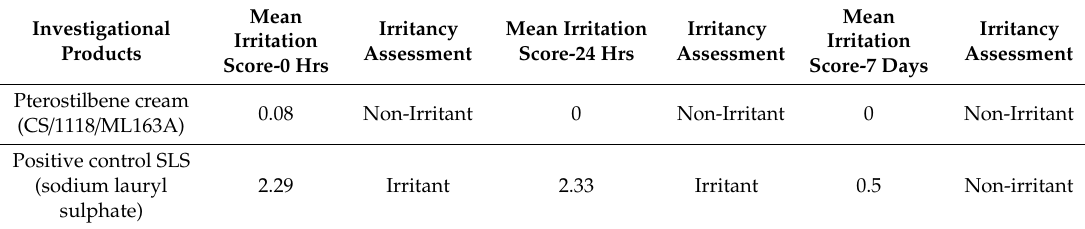
Table 3. Primary skin irritation assessments.